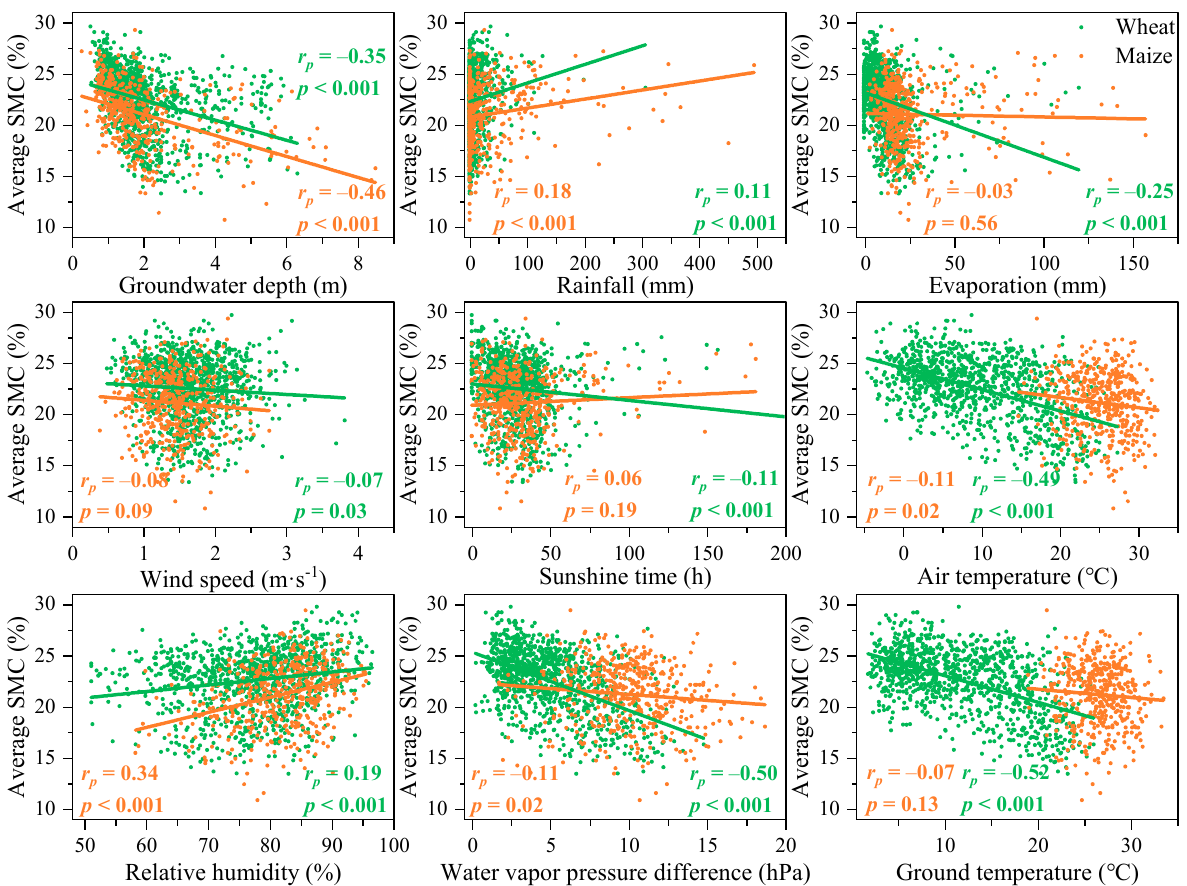
Figure 4. Relationship between average soil moisture content and influencing factors. By analyzing the correlation between meteorological factors, groundwater depth, crop growth period, and SMC of different layers, it is found that the correlation coefficients of air temperature with ground temperature and water vapor pressure difference are 0.98 ( p < 0.01) and 0.84 ( p < 0.01), respectively. We also removed air temperature to analyze the influence of the remaining nine factors on SMC. To explore the contribution of different influencing factors on SMC, RDA analysis was used for this study. In our study, 1 represents the wheat (maize) emergence–tillering period (seeding–emergence period); 2 represents the wheat (maize) tillering–wintering period (jointing–booting period); 3 represents the wheat (maize) regreening–jointing period (heading–flowering period); and 4 represents the wheat (maize) heading–mature period (grouting–mature period). Before the RDA analysis, a detrended correspondence analysis (DCA) was first performed on the SMC of wheat and maize land, and it was found that the maximum gradient length was less than 3, indicating that the contribution of influencing factors to SMC could be analyzed by RDA.